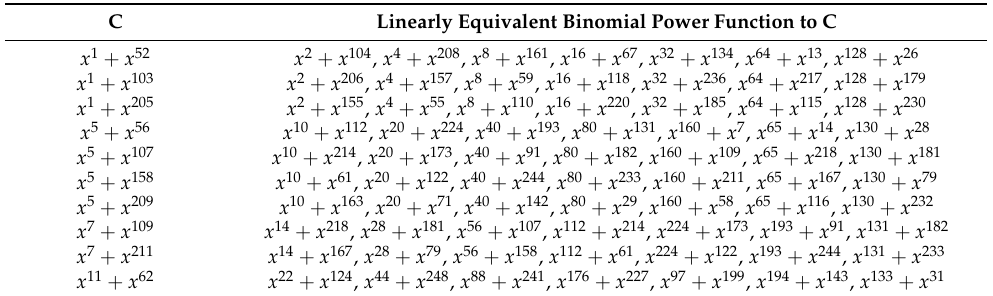
Table A4. Classification of Linearly Non-Equivalent Binomial Power Function with 51 to 1